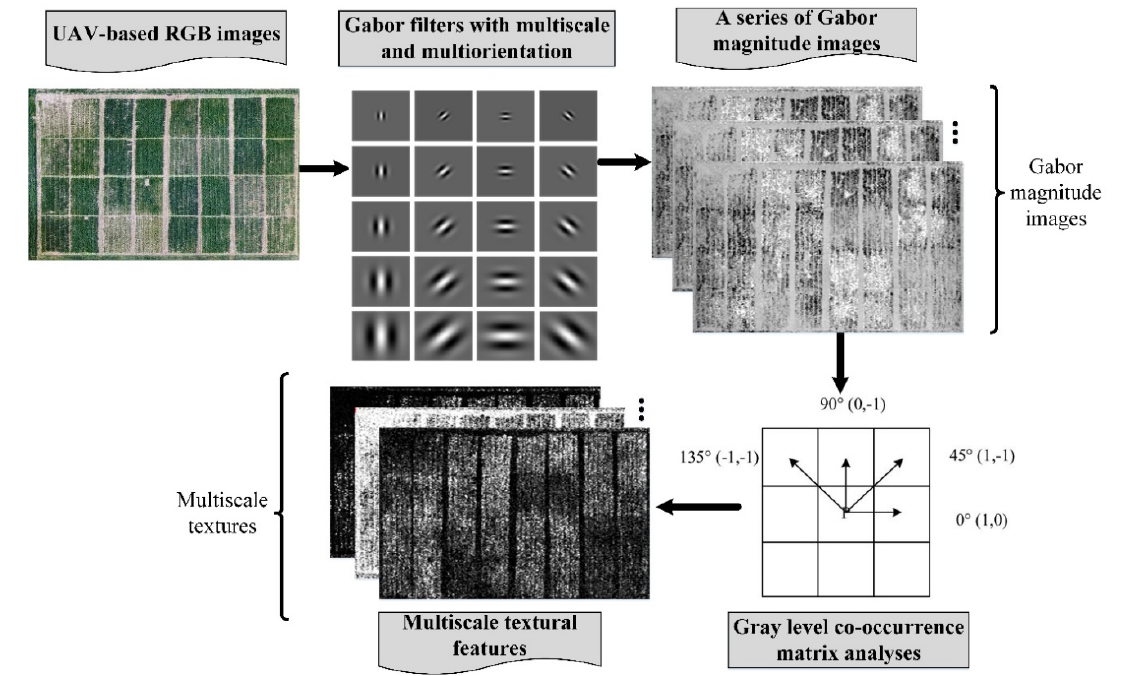
Figure 1. System block diagram of the proposed multiscale texture extraction method (Multiscale_Gabor_GLCM).